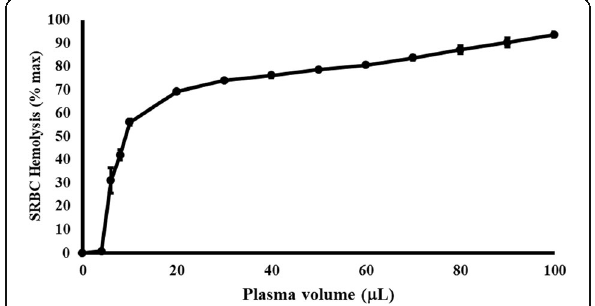
Fig. 1 Concentration-dependent hemolysis of sheep red blood cells (SRBCs) by plasma derived from Crotalus viridis . The samples were centrifuged, and the optical densities of the supernatants were measured at 540 nm and expressed as the % maximum as compared to a hemolysis positive control. The results represent the means ± standard deviations for four independent